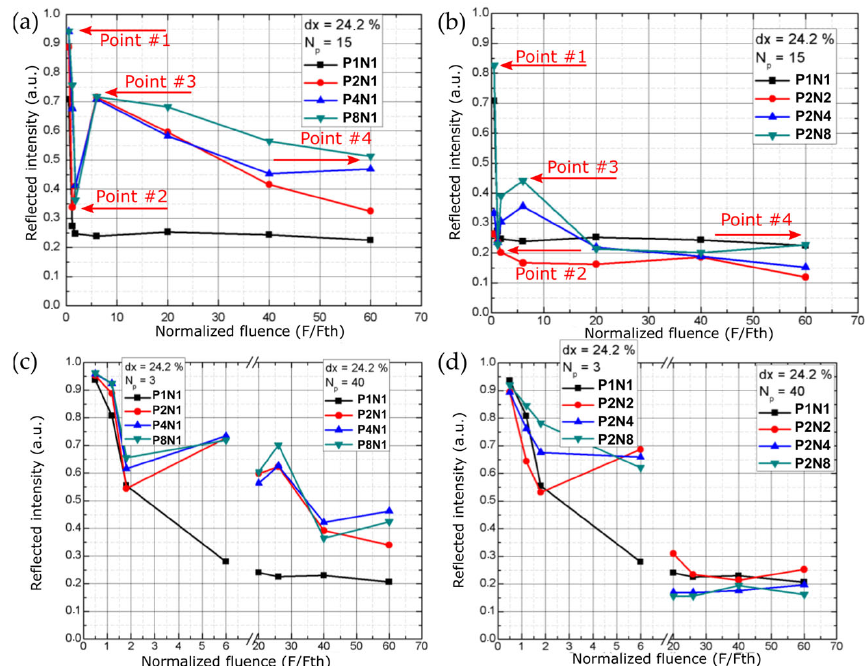
Figure 2. Brightness measurement results when scanning the 2 mm × 2 mm squares multiple times using different pulse energy settings and different burst mode configurations. dx denotes the spatial overlap of the pulses, Np denotes the number of scans (layers) on the surface. ( a ) Reflected intensity values as a function of the normalized fluence for different GHz burst modes. ( b ) Reflected intensity values as a function of the normalized fluence for different BiBurst modes. ( c ) Reflected intensity values as a function of the normalized fluence for different GHz burst modes when performing a different number of scans (layers). ( d ) Reflected intensity values as a function of the normalized fluence for different BiBurst modes when performing a different number of scans